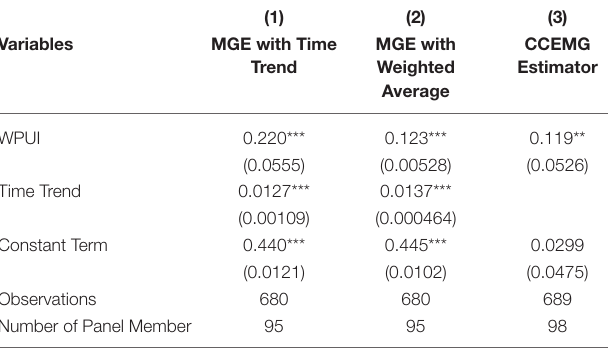
TABLE 3 | Results of the heterogeneous panel